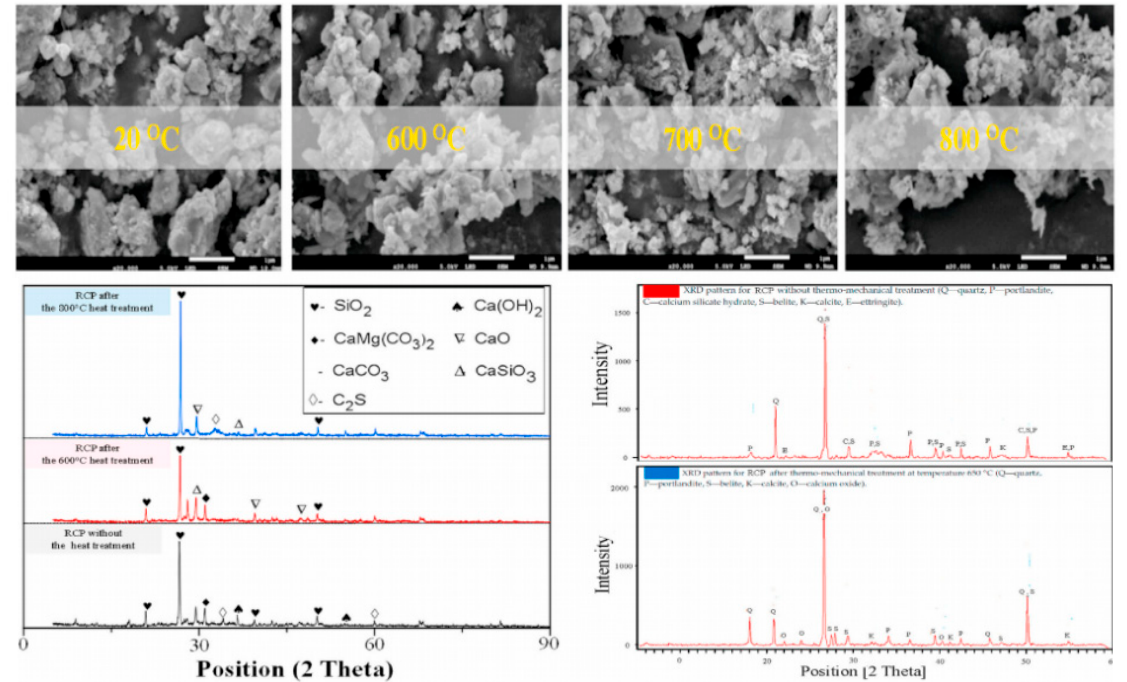
Figure 6. SEM images of RCP under different heat treatment